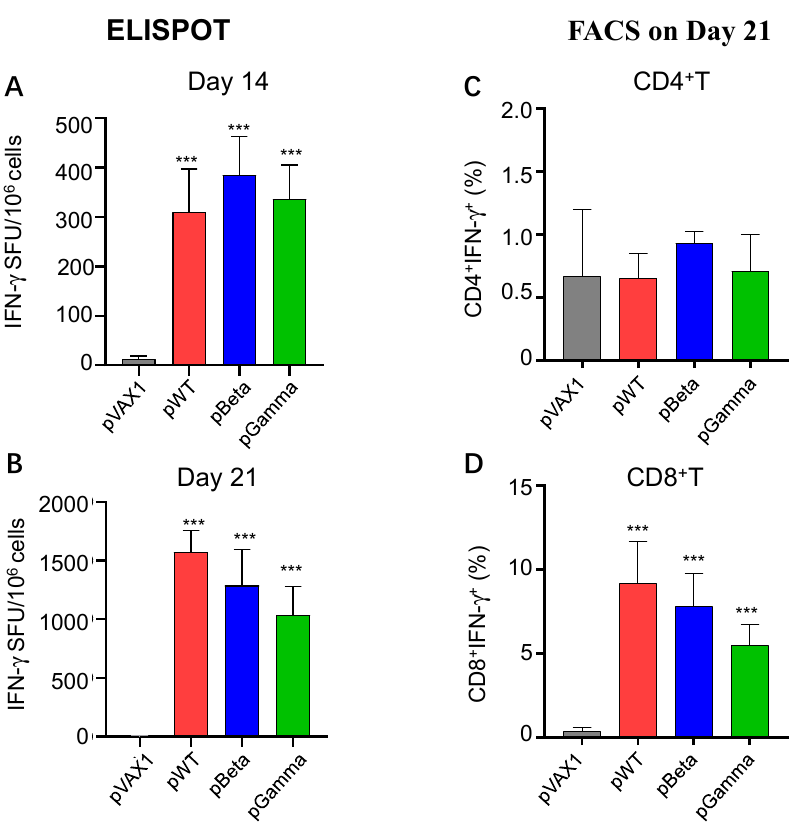
Figure 3. ELISPOT and FACS analysis of splenocytes from mice immunized with various DNA vaccines. Splenocytes were harvested on days 14 and 21 post-immunization and stimulated with an RBD peptide pool of wild-type SARS-CoV-2. ELISPOT was performed to observe IFN γ -secreting cells on days 14 and 21. ( A ) Spot forming unit (SFU) per million splenocytes of pWT, pBeta, and pGamma on day 14 ( n = 3), ( B ) SFU per million splenocytes on day 21 ( n = 3). ( C ) A percentage of IFN γ + CD4 + T cells in vaccinated mice on day 21 by FACS, ( D ) a percentage of IFN γ + CD4 + T cells in vaccinated mice on day 21 by FACS. *** denotes a significant difference compared with pVAX1 ( p < 0.001).